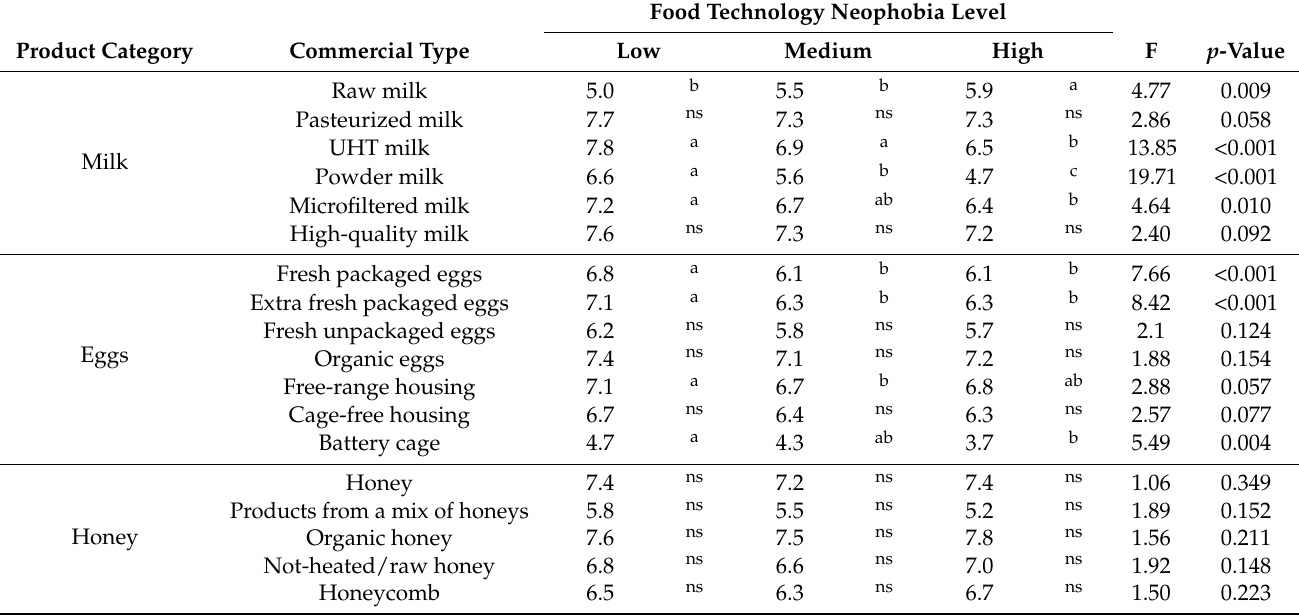
Table 3. Effect of the food technology neophobia on the perceived safety of different